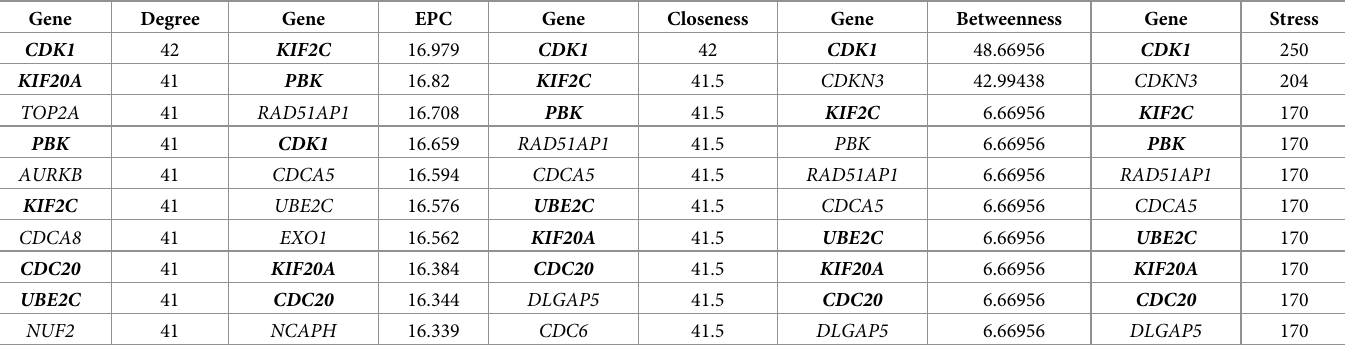
Table 4. The top 10 genes in the PPI network were calculated using five algorithms.